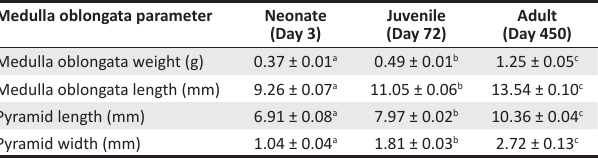
TABLE 3: Age-specific allometry of the medulla oblongata in the African grasscutter (mean ± SEM). Medulla oblongata parameter